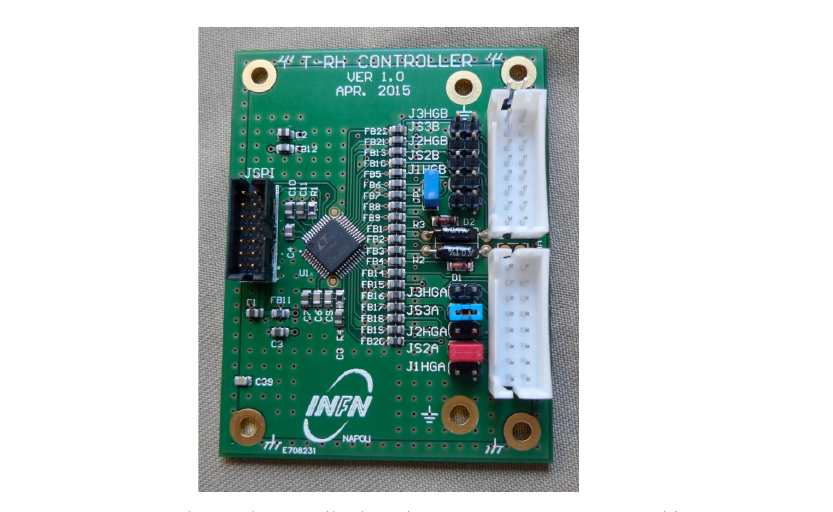
Figure 4. Normal Mode Rejection Ratio measurement scheme.